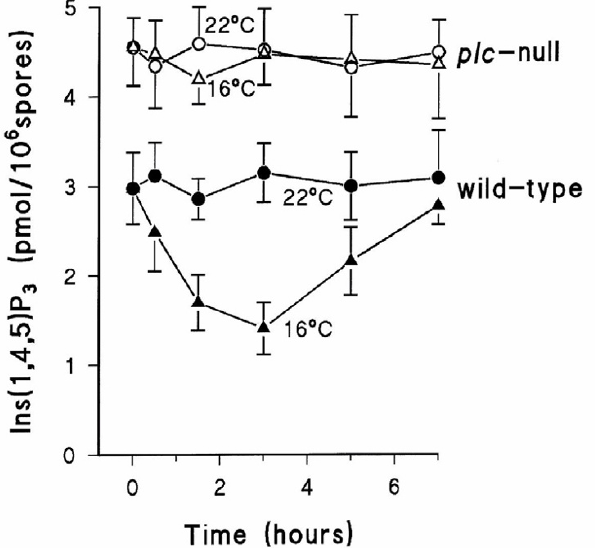
Figure 3 IP 3 formation in germinating spores. Wild-type and plc - null spores were incubated in growth medium at 22 ° C or 16 ° C. At the times indicated samples were withdrawn and assayed for the IP 3 content using an isotope dillution assay. The means and standard deviations of triplicate determina- tions from two independent experiments are shown.